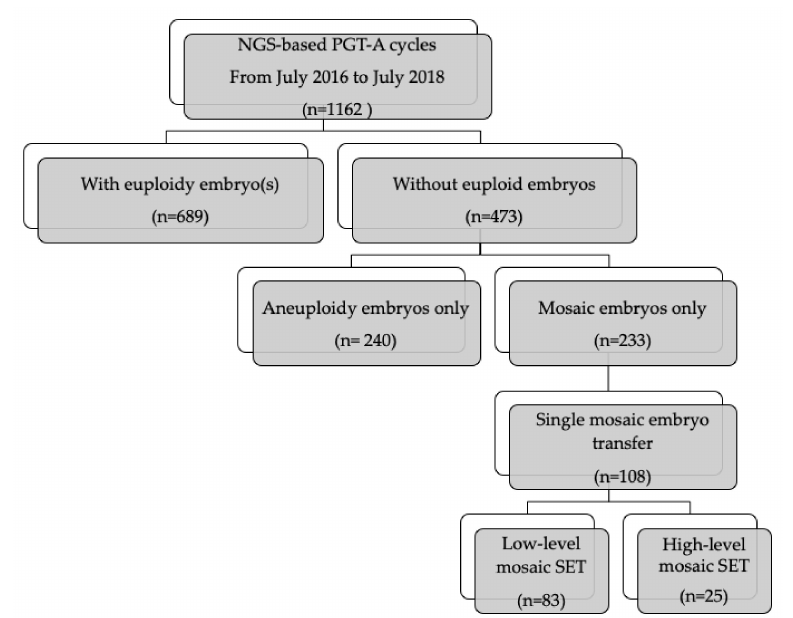
Figure 1. Flowchart of study